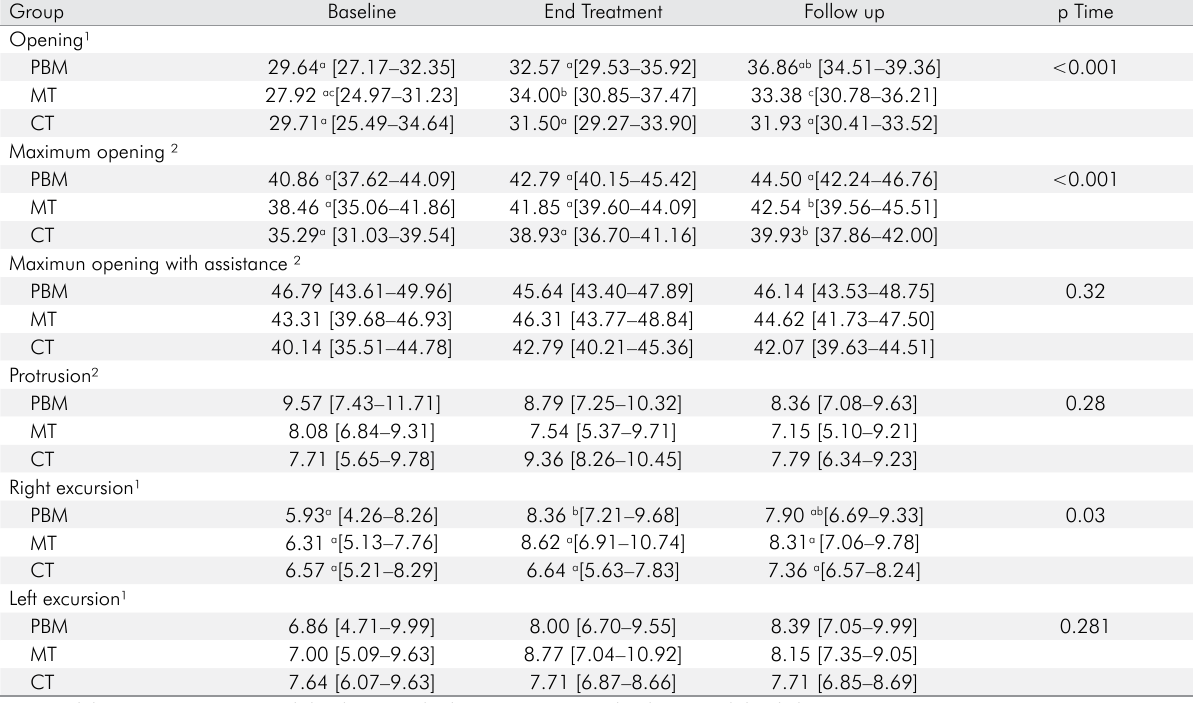
Table 3. RDC Axis I: Assessment of jaws movements (mm) at baseline, end of the treatment, and follow up of patients treated with different protocols. Média (IC95%)